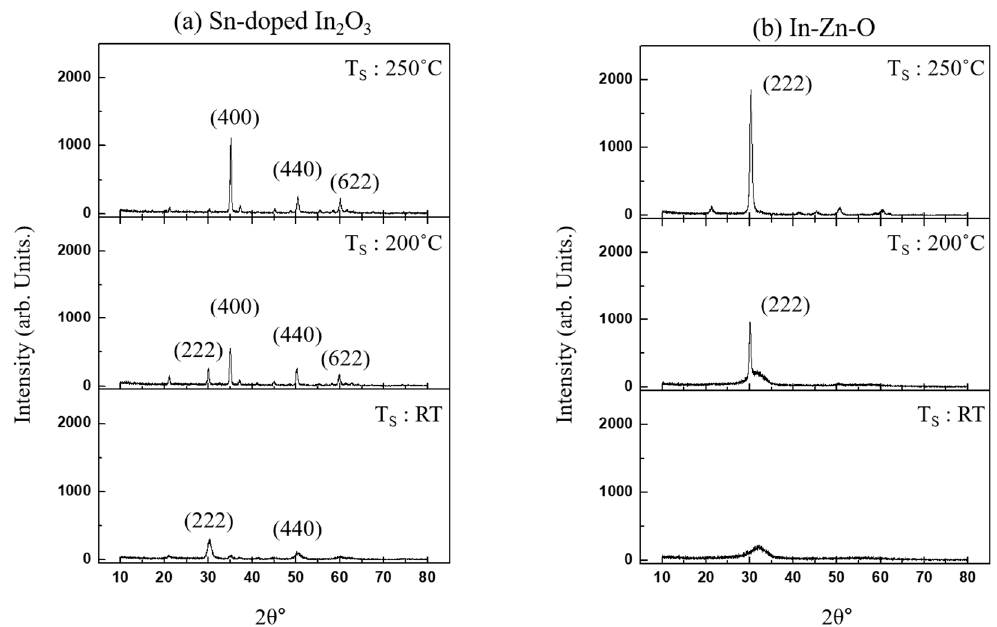
Figure 5. XRD patterns of ( a ) c-ITO and ( b ) a-IZO films with a thickness of 1 µ m deposited under Figure 5 . XRD patterns of ( a ) c ‐ ITO and ( b ) a ‐ IZO films with a thickness of 1 μ m deposited under various substrate temperatures ( T S : RT, 200, and 250 ◦ C) are compared. The IZO grown at RT shows various substrate temperatures ( T S : RT, 200, and 250 °C) are compared. The IZO grown at RT shows the amorphous state. the amorphous state.